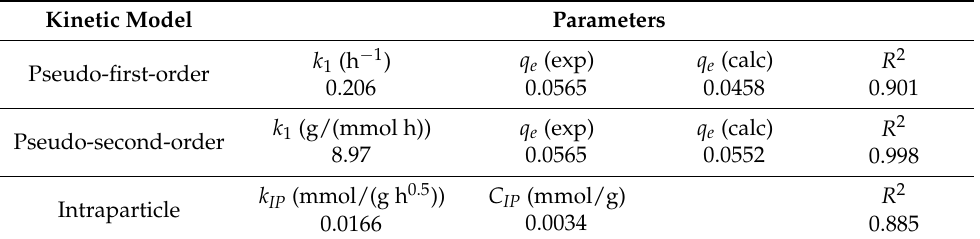
Table 2. Kinetic parameters and coefficients of